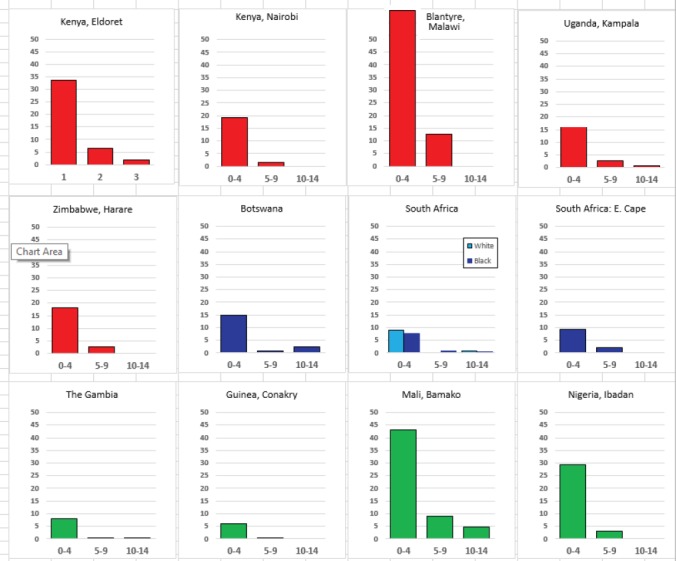
Age-specific histograms – retinoblastoma.